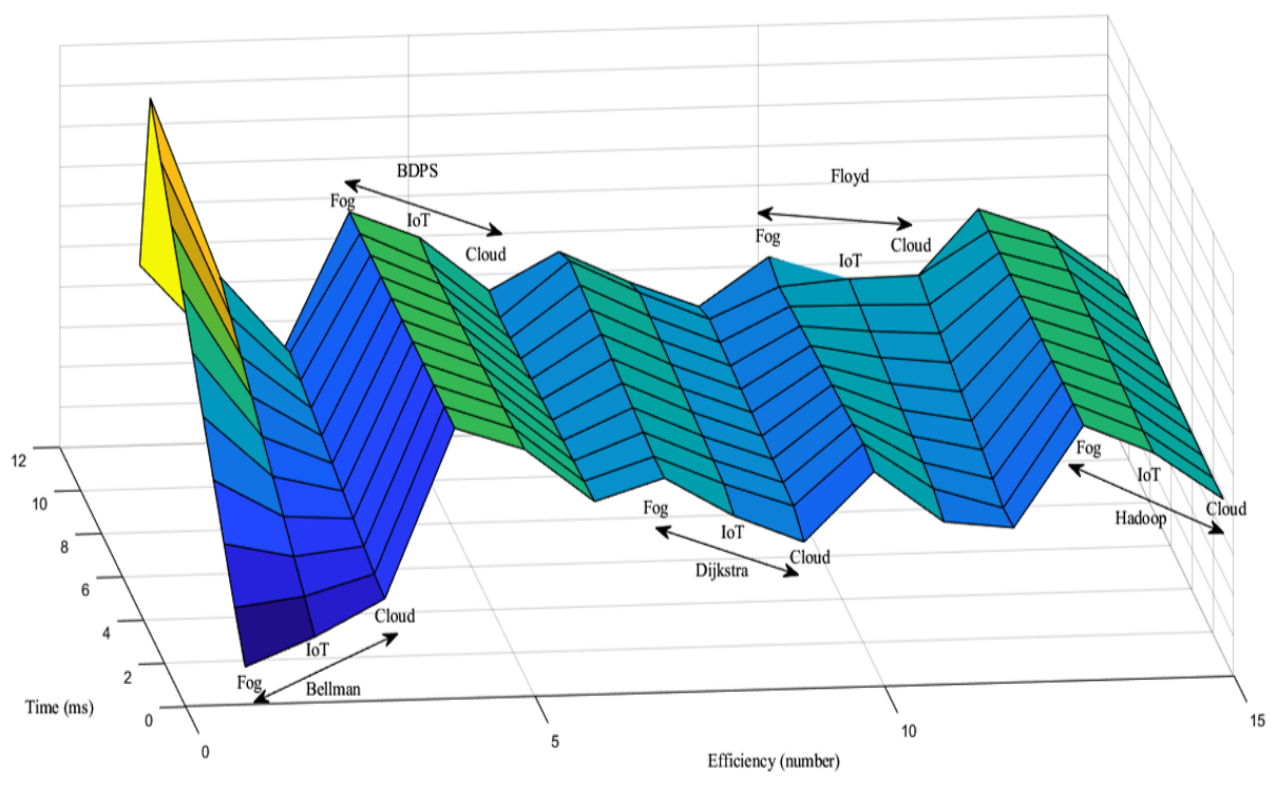
Figure 8. Network efficiency generation scenario over the FW, AH, BF, DA and BDPS algorithms in cloud, fog, and IoT